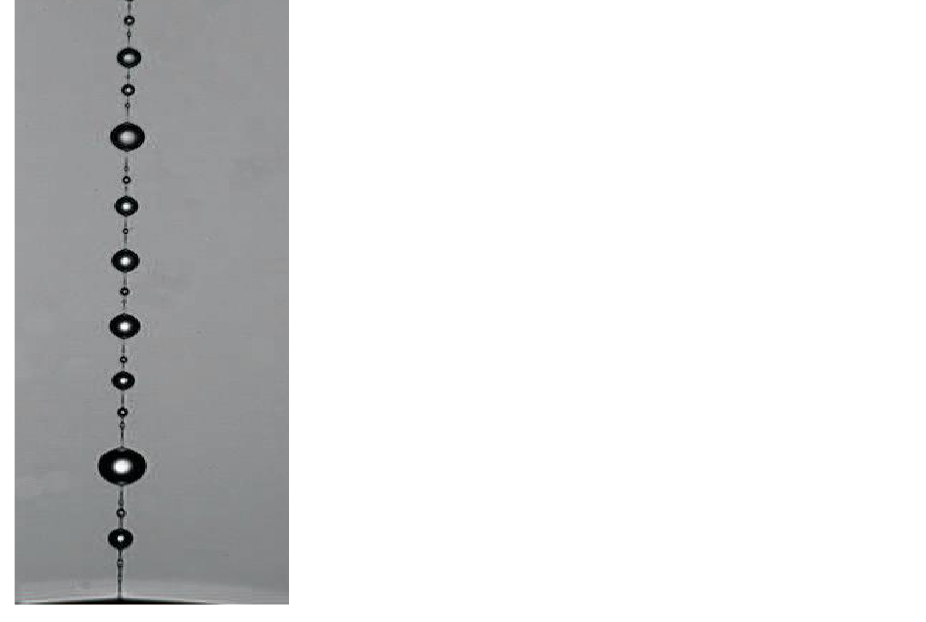
Figure 32. Beads-on-string structure occurring at stretching of polymer solutions.